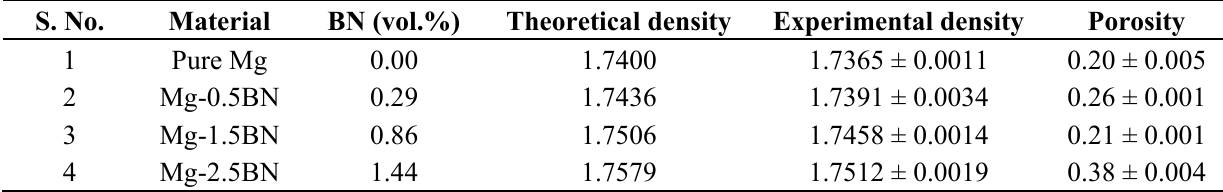
Table 1. Results of density and porosity